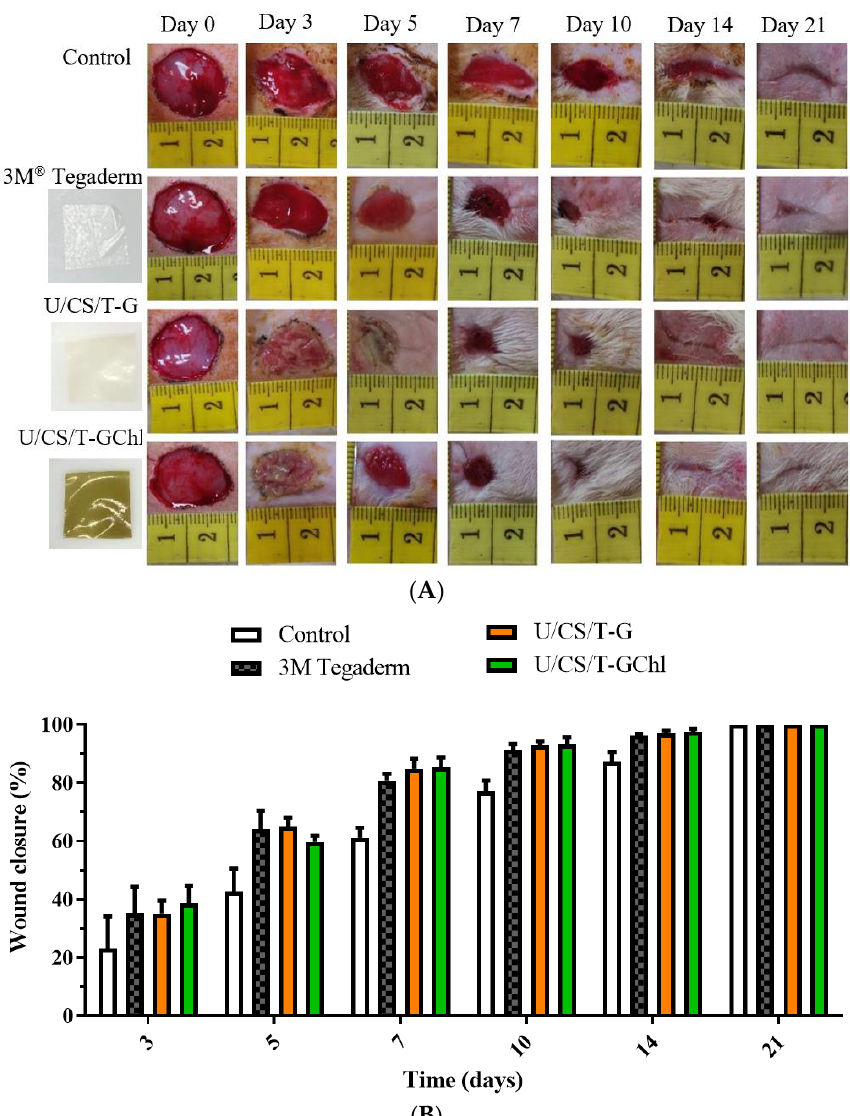
Figure 8. ( A ) Photographs of all skin layer wounds covered with a commercial dressing and the ulvan/chitosan complex films on SD rats at several specific days (0 – 21 days) after surgery. ( B ) Wound closure percentage of all skin layer wounds on SD rats at several specific days (3 – 21 days) after surgery. The control group is the open wound without any dressing.